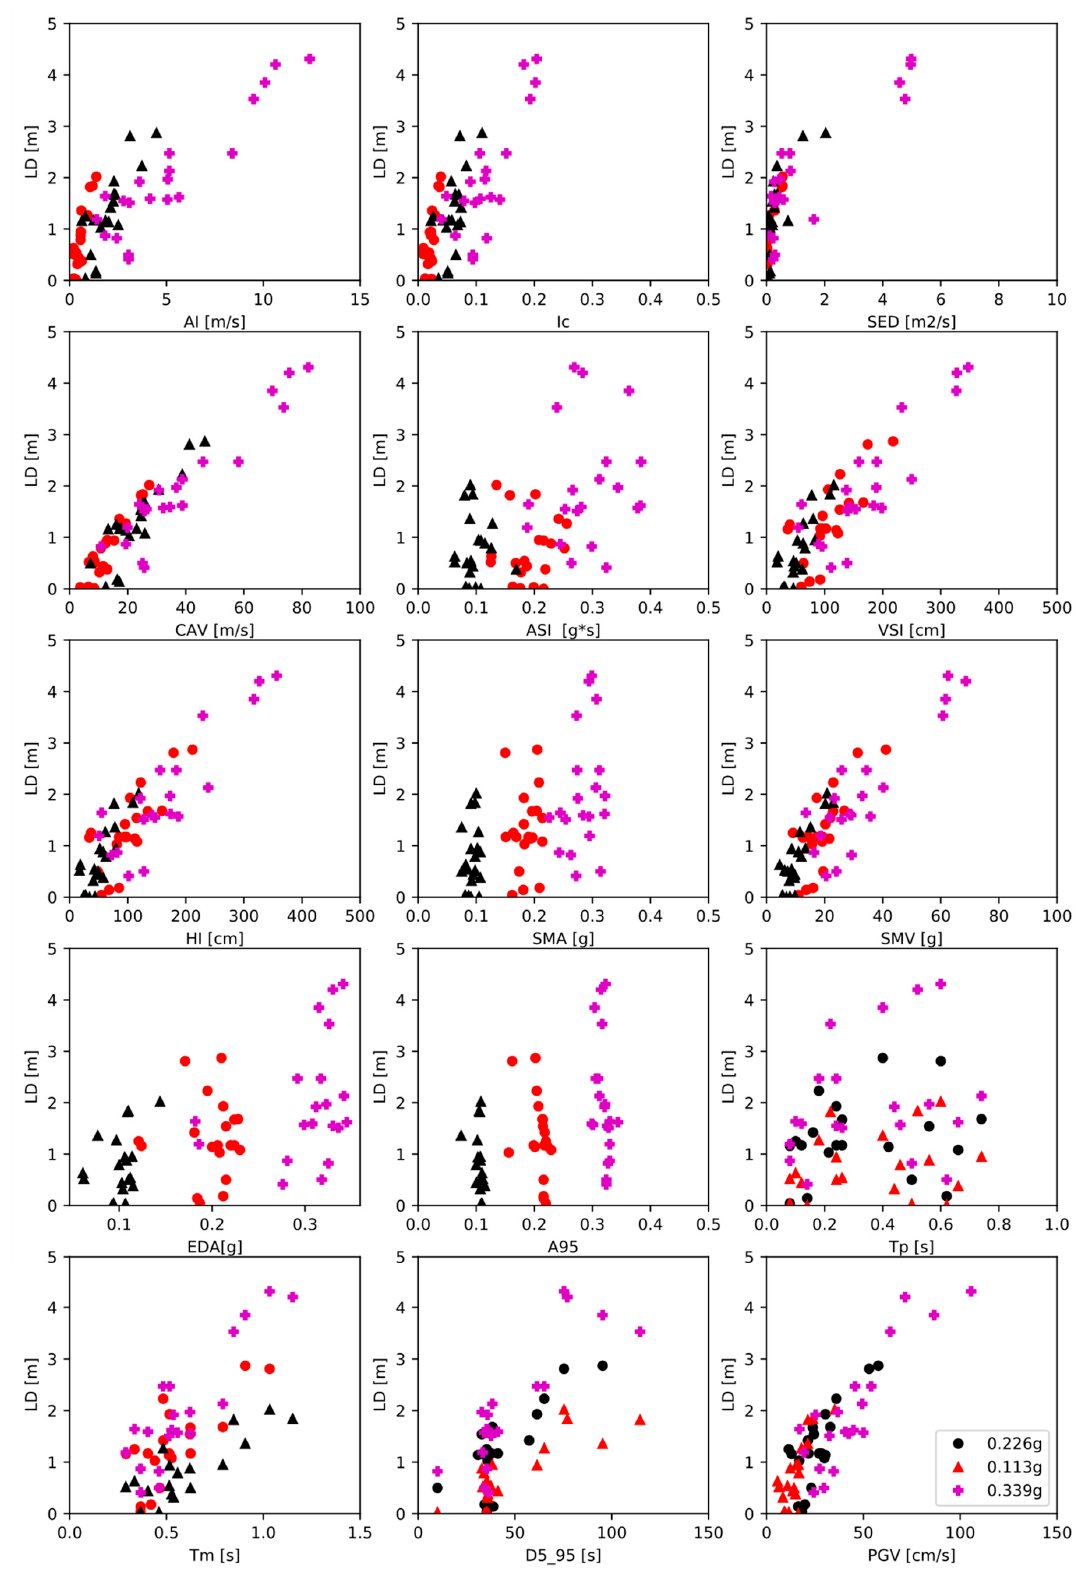
Figure 21. Relationship between the selected intensity measures (IM) and lateral displacement (LD).